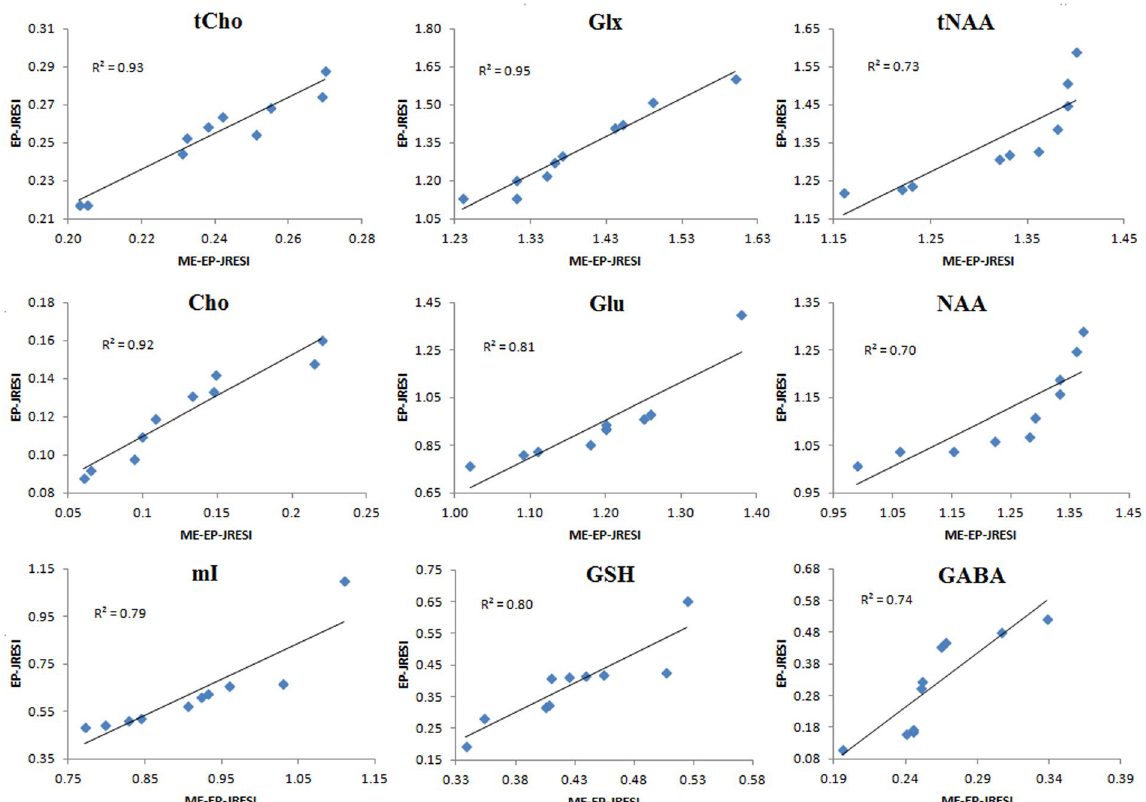
Figure 5. Correlations and R 2 values between metabolite ratios of the phantom data from ME-EP-JRESI and EP-JRESI sequences for the 10